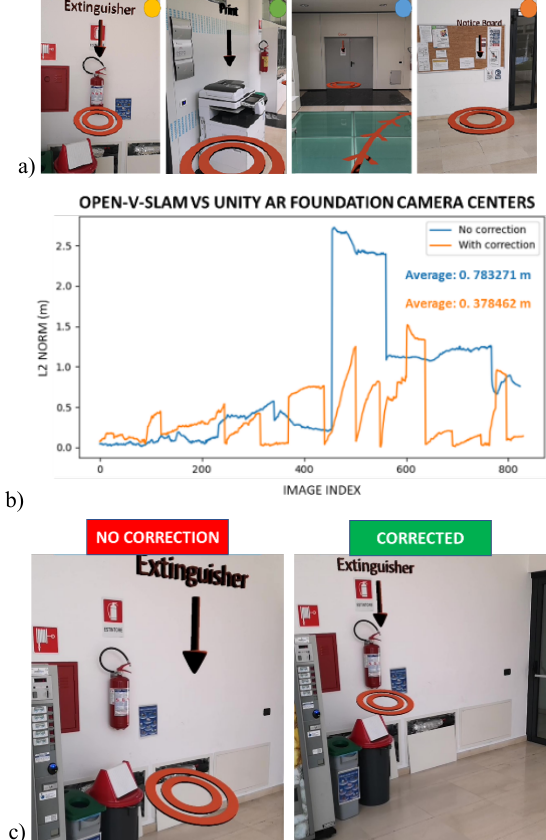
Figure 4 . Visual impressions of the OPEN-V-SLAM accuracy localization (a). Plot of the L2 NORM of the difference of the camera centers with/without correction (b). Effects of the proposed correction step (c).